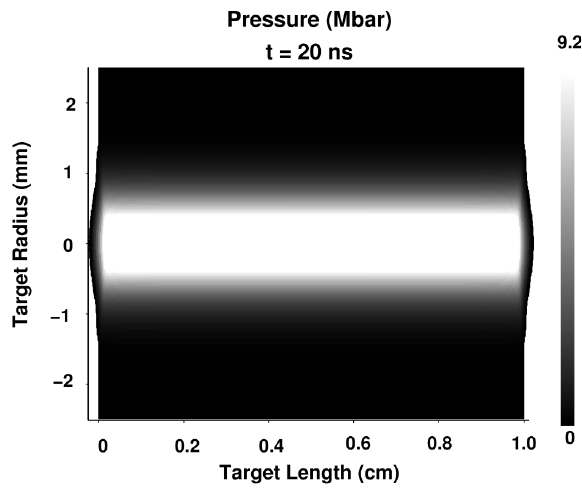
FIG. 6. Pressure corresponding to the case shown in Fig. 5.